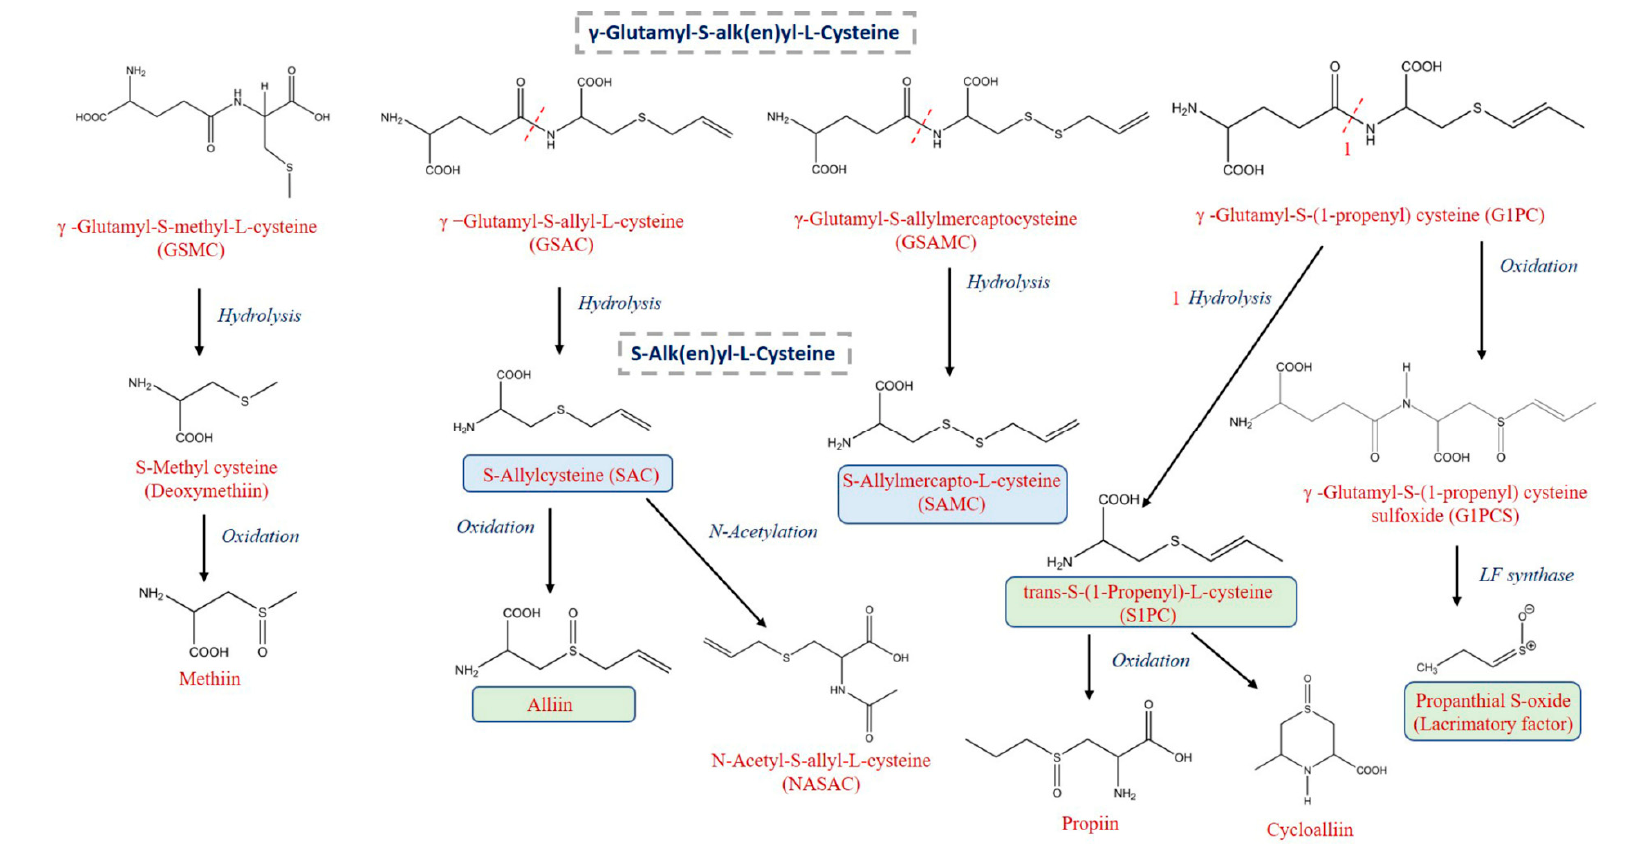
Figure 4. Proposed breakdown pathway of organosulfur compounds during in vitro gastrointestinal digestion.